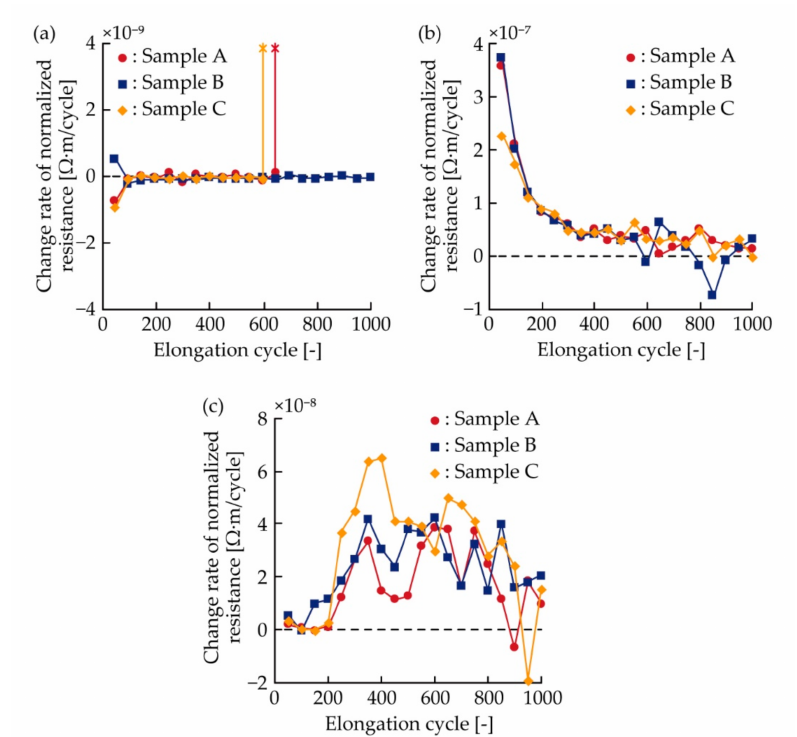
Figure 9. Change rate of normalized resistance against the elongation cycle of one cycle in Figure 8a–c; ( a ) meandering copper, ( b ) silver ink, and ( c ) double-layered patterns.